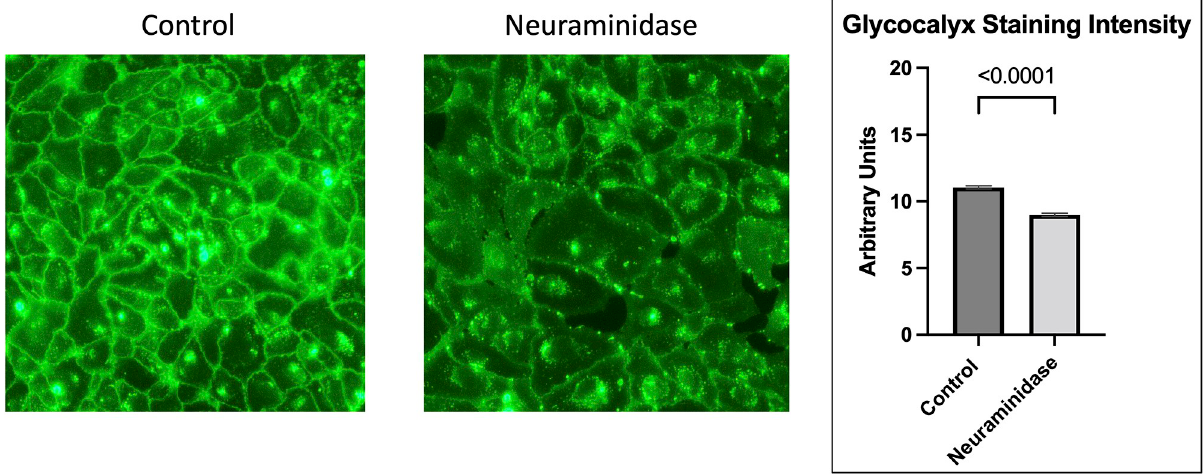
Fig 10. Neuraminadase’s role in glycocalyx shedding. Representative images and comparison of glycocalyx staining intensity shows that neuraminidase alone causes decreased glycocalyx staining intensity when compared to control human umbilical vein endothelial cells.